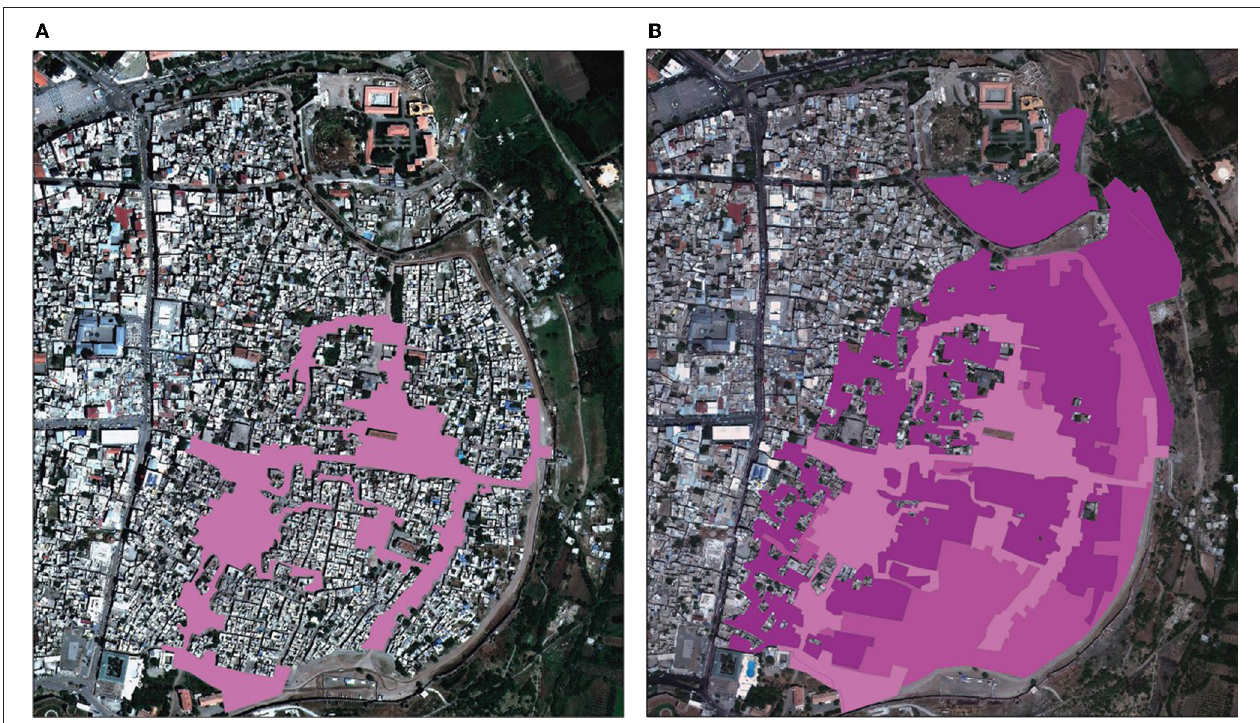
FIGURE 2 | (A,B) Demolitions by 10 May 2016 and by 11 July 2017 demonstrated by